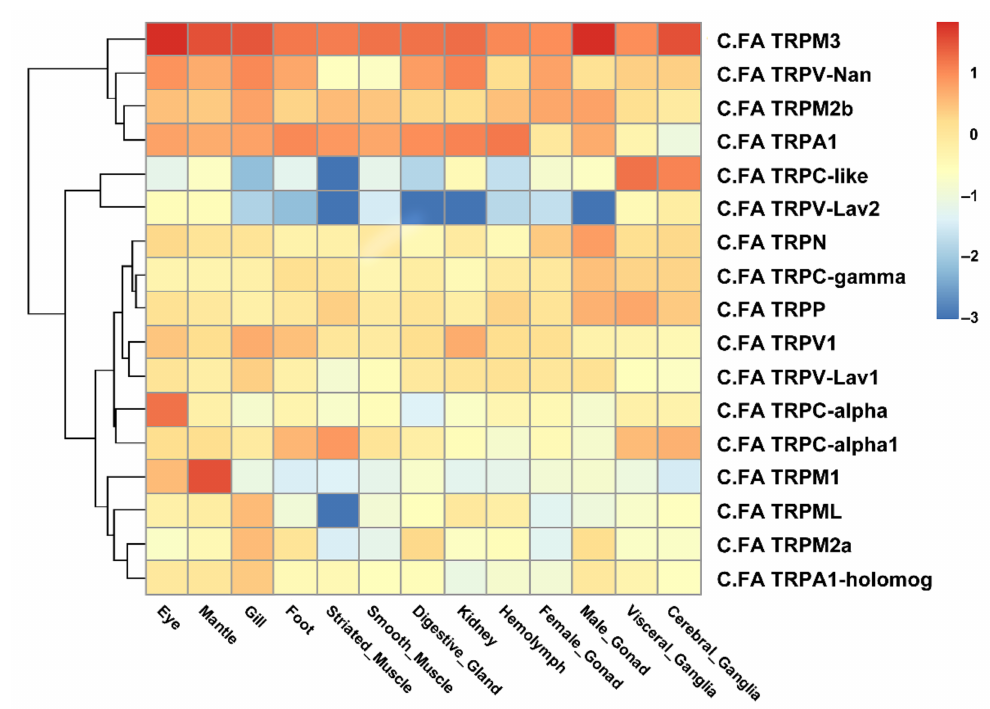
Figure 5. A heat map summarizing the expression of C.FA TRP genes in different adult tissues based on the Log 10